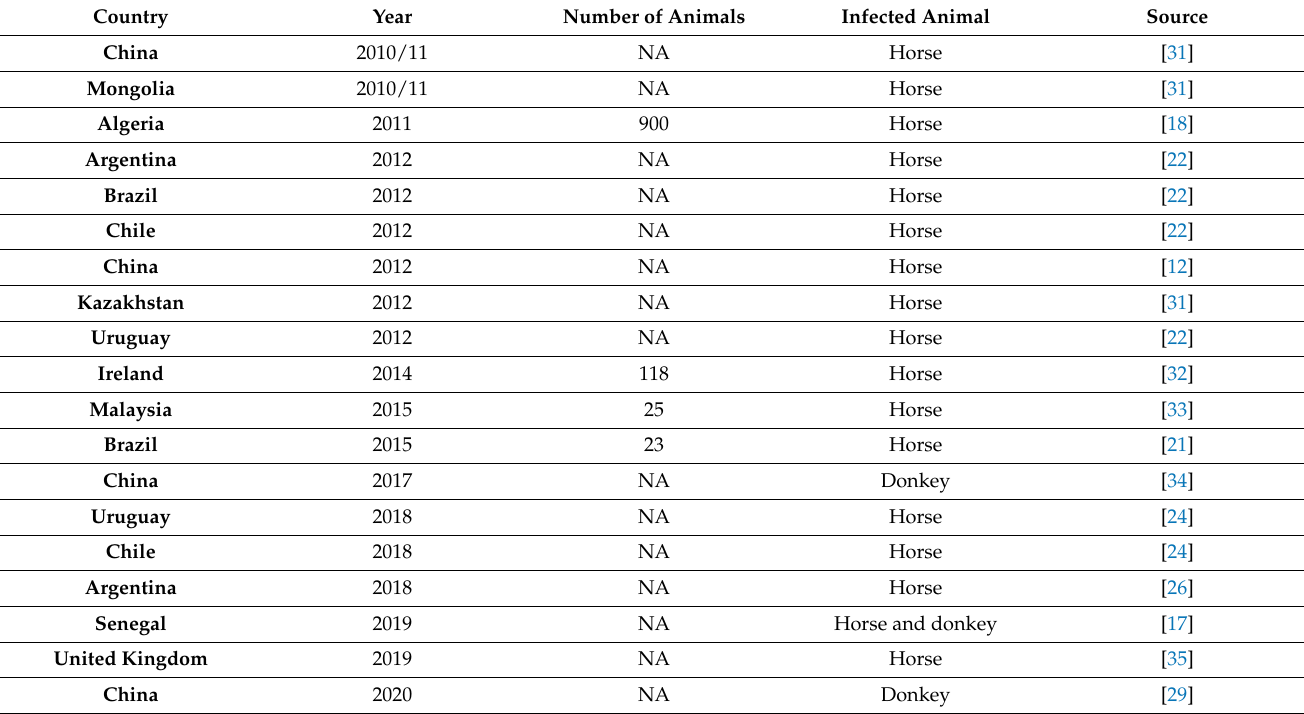
Figure 1. Origin and mode of transmission of EIV: Aquatic birds serve as the natural reservoir of avian influenza, a progenitor of EIV. Following infection of a horse, the virus can be spread to other animals in aerosolized droplets by coughing or through fomite transmission. International transport of horses facilitates the spread of the virus to new geographical locations, especially during horse events such as racing or shows. Dogs can also become infected and transmit the virus to other dogs. Table 1. Selected EI outbreaks in the past